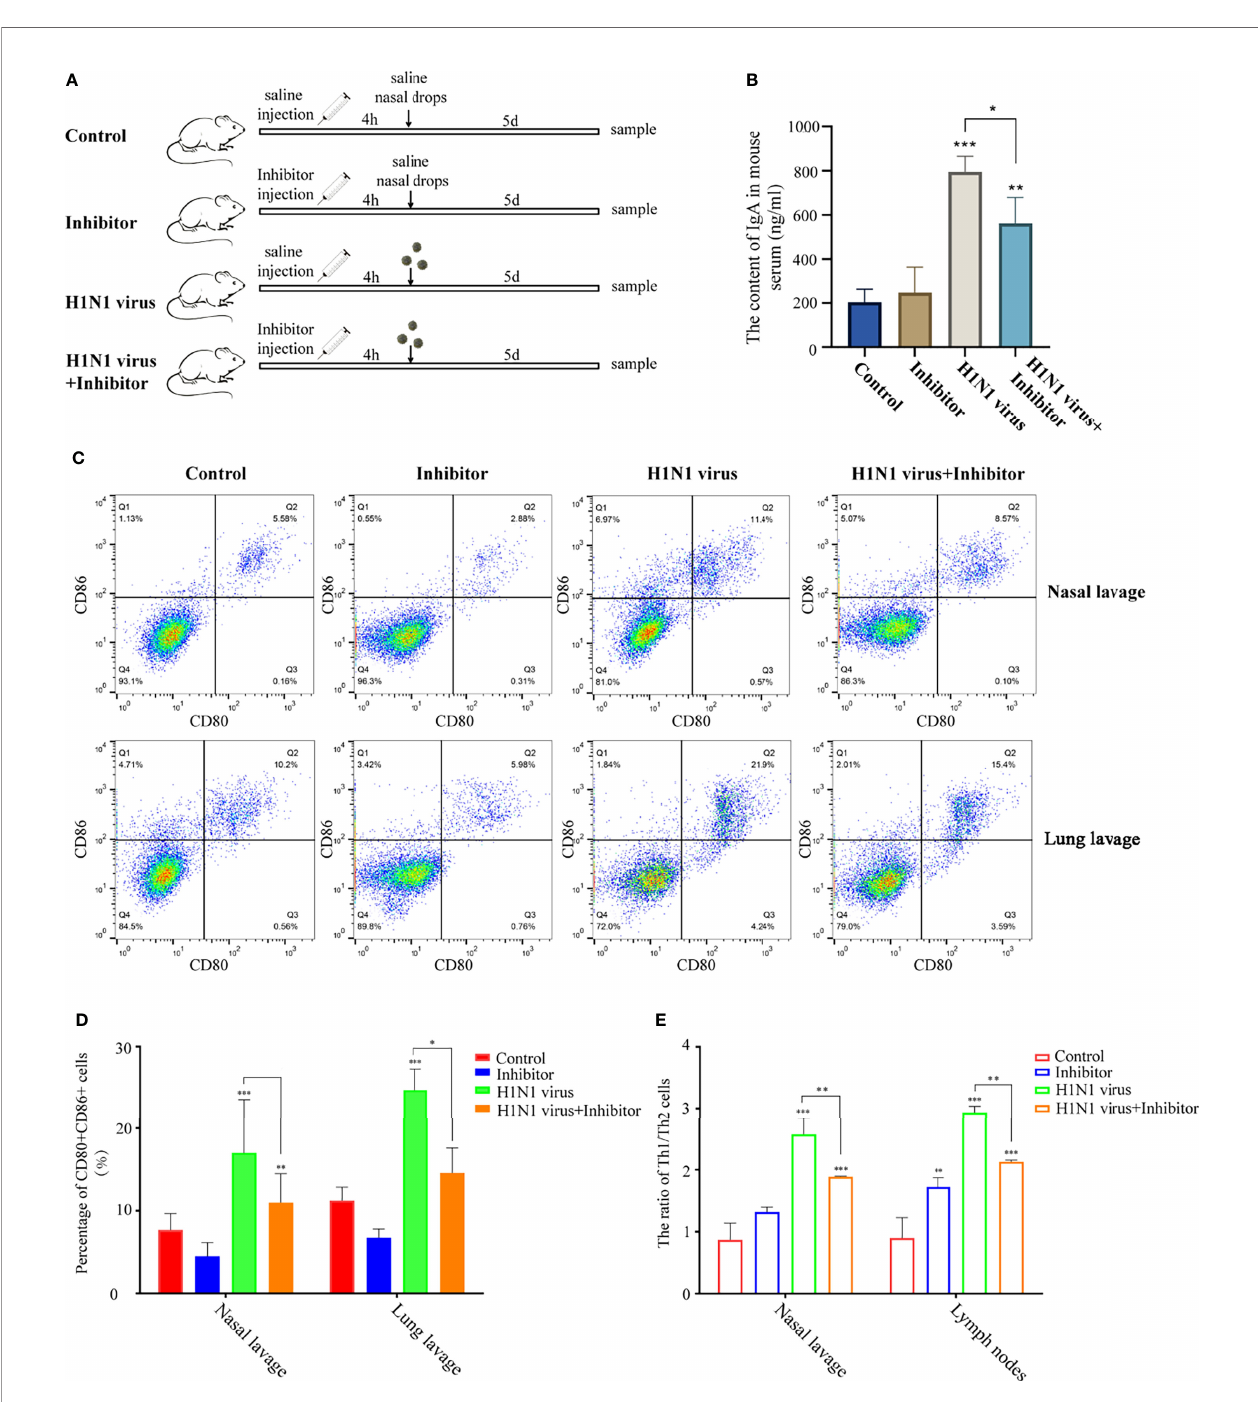
FIGURE 8 | Arginase inhibitor 1 attenuates H1N1 virus infection-induced immune responses in mice. (A) Experimental procedure for drug injection in mice. Arrows indicate the drug injection time point.Mice in the control group were injected with the same amount of saline nasal drops at the same time point. (B) Elisa was used to detect IgA levels in mouse serum after H1N1 virus infection and arginase inhibitor 1 intervention. (C) Flow cytometry was used to detect the proportion of CD80+CD86+ DCs in nasal lavage fl uid and lung lavage fl uid of mice after H1N1 virus infection and arginase inhibitor 1 intervention. (D) The bar graphs show quanti fi cation of the fl ow cytometry results, with each value represents the mean ± SD of three independent experiments. (E) Statistical chart of the ratio of Th1/Th2 in nasal lavage fl uid and lymphoid tissue of mice detected by fl ow cytometry. Statistical signi fi cance is shown using the Student ’ s t test analysis, *P < 0.05; **P < 0.01; ***P <